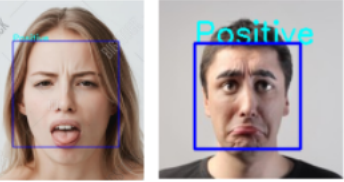
Figure 25. Incorrectly Classified Images 2 × Negative.